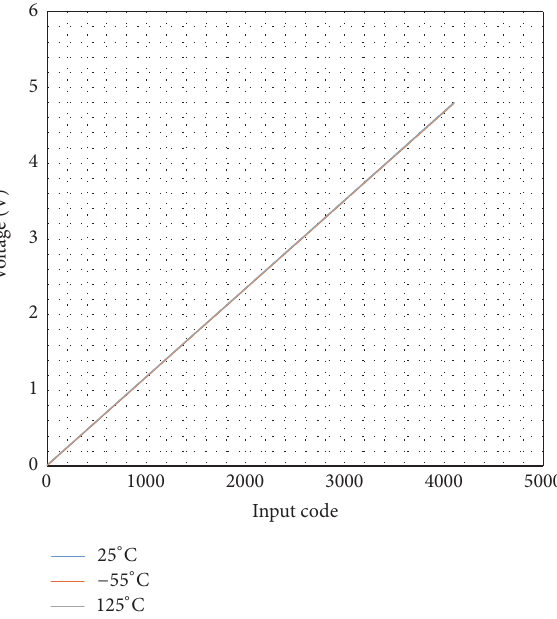
Figure 9: DAC output with different input